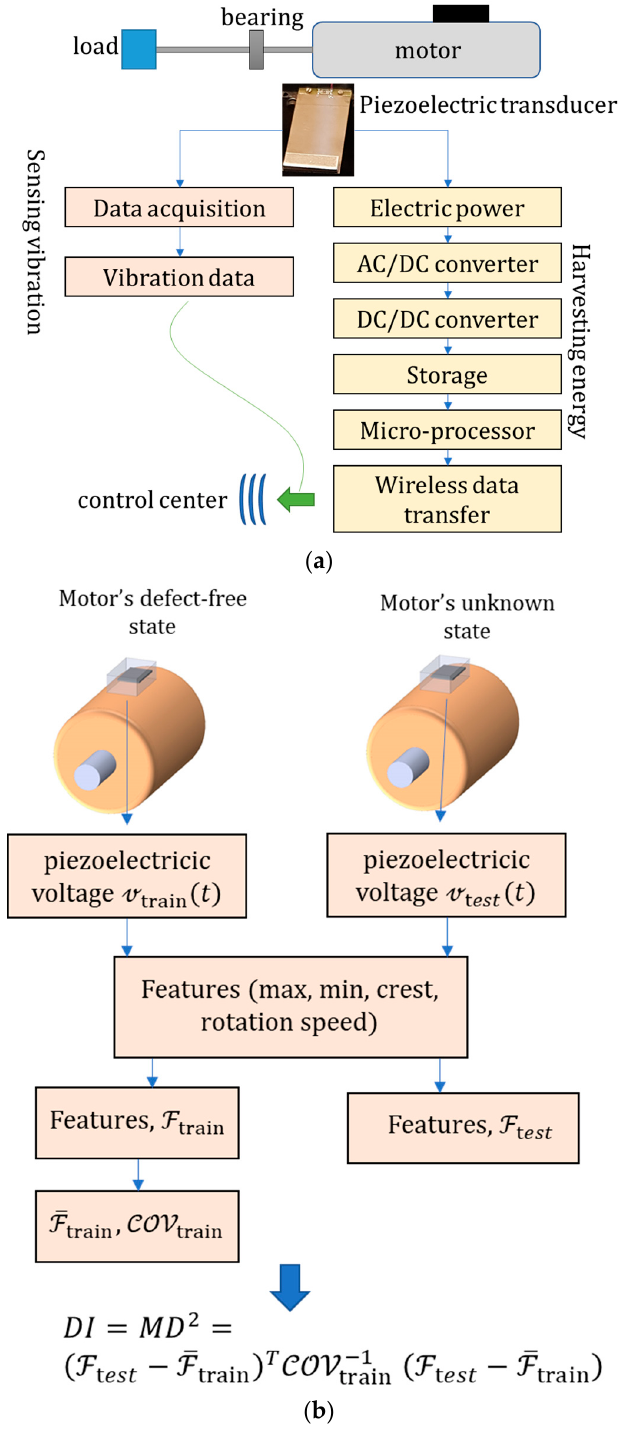
Figure 1. ( a ) Flowchart of the online condition monitoring by a self-powered piezoelectric transducer, and ( b ) flowchart of the fault detection by the outlier method using Mahalanobis Distance (MD).